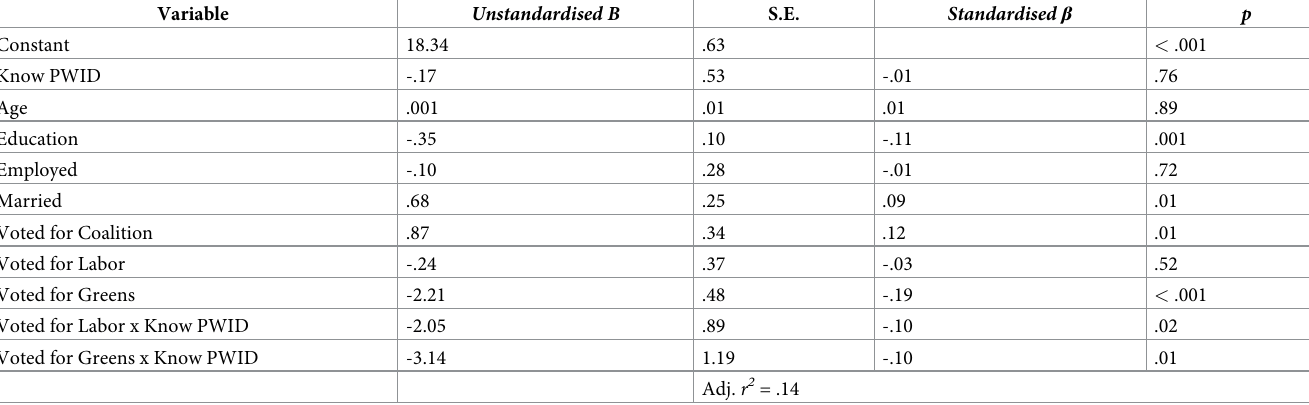
Table 6. Multiple regression results with people who inject drugs stigma scale scores as the dependent variable.